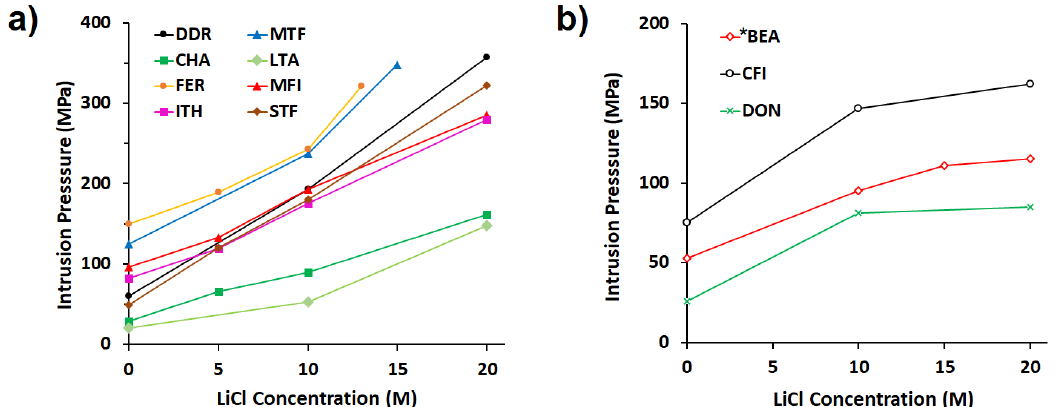
Figure 4. Evolution of the intrusion pressure values with LiCl concentration for ( a ) zeosils with narrow pore openings (8, 9, and 10 MR), ( b ) zeosils with large pore openings (12 and 14 MR). Only the intrusion of samples investigated with at least three different concentrations are considered.